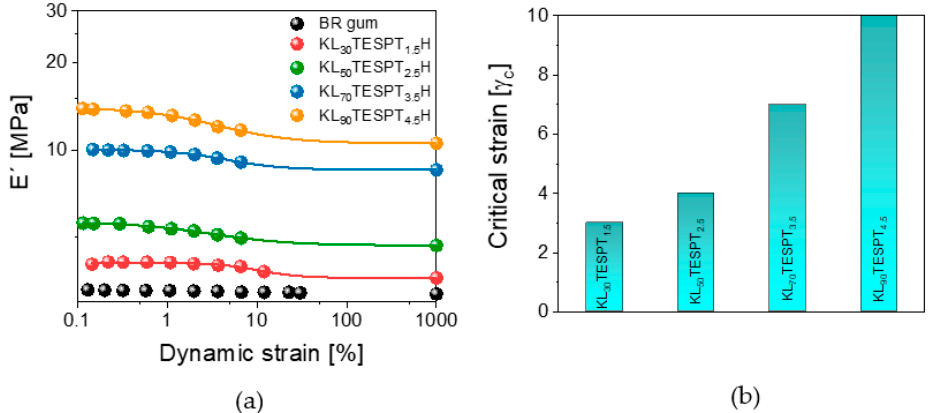
Figure 4. ( a ) Storage modulus as a function of dynamic strain amplitude (solid dots and solid lines represent the experimental values and the values fitted with Kraus equation, respectively) of gum BR and BR/kraft lignin (KL)/TESPT composites. ( b ) Variation of critical strain ( γ c ) of different lignin-loaded BR composites.